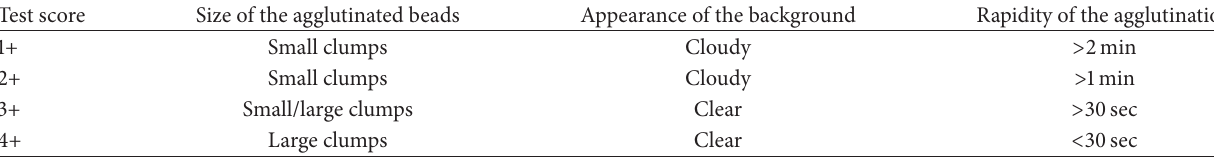
Table 1: Test score for qualitative latex agglutination test for VWF :Ag.